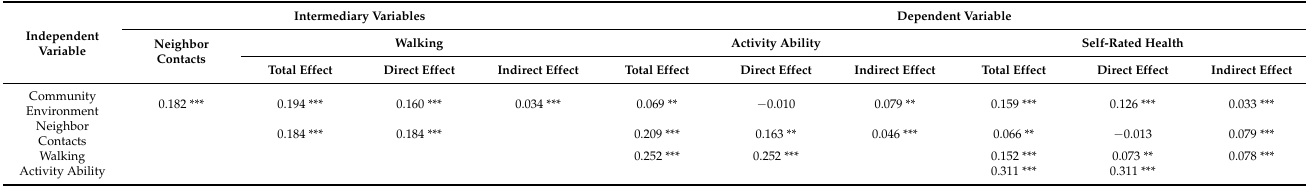
Table 2. The model paths of the whole sample.